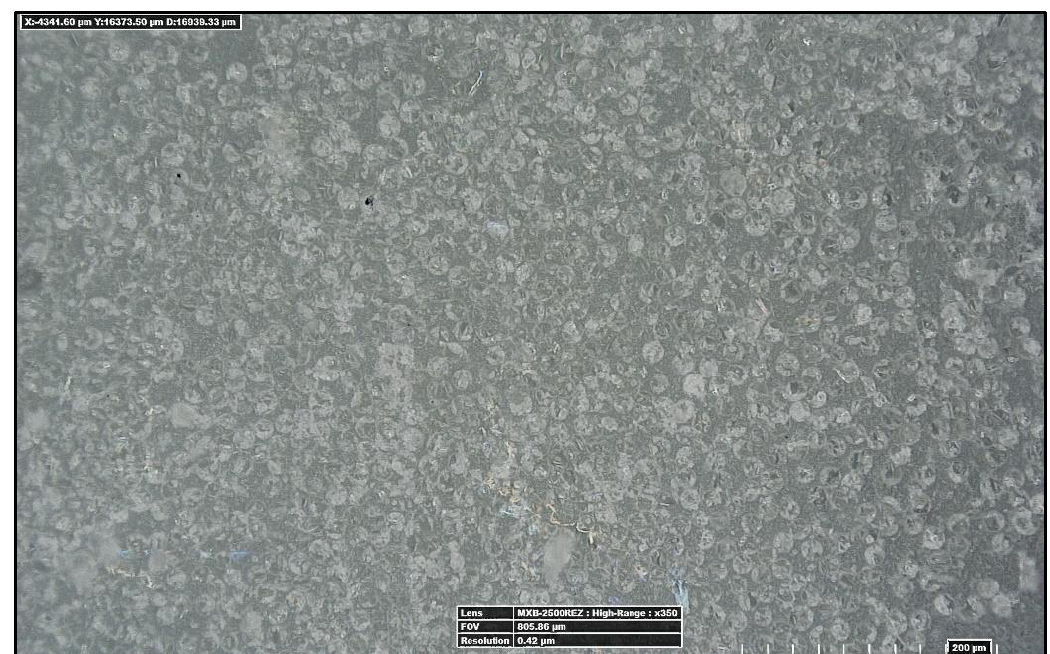
Figure 7. R-glass FRP plate with a ( bottom ; ×350 magnification) transverse and ( top ; ×350 magnification) hoop fiber orientation after a week of exposure to pH 10.0 aqueous solution.